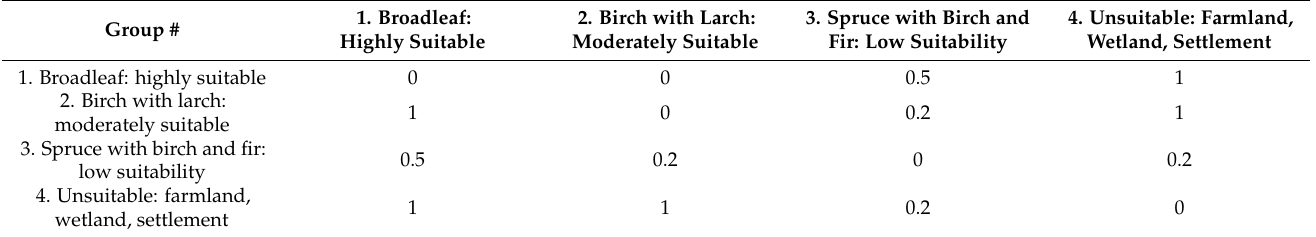
Table A3. Contrast matrix between groups of habitats used for calculation of edge contrast index.